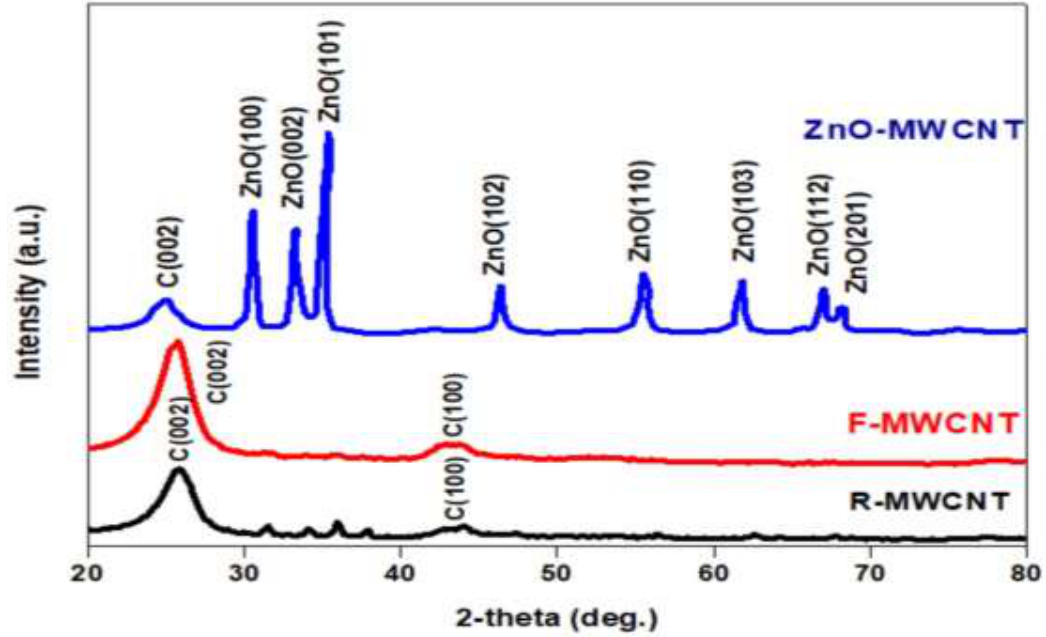
Figure 2: XRD spectra of R-MWCNTs, F-MWCNTs, and ZnO/MWCNTs hybrid. Figure 3 a & 3 b displays the FE-SEM images of the R- MWCNTs before the acid treatment. It was noticed that the R-MWCNTs appears as cylindrical tubes shape with different directions. In addition, the particles tend to agglomerate according to Van der Waals forces between the tubes. After the acid treatment of the F-MWCNTs, it was notable that there was a significant difference in the FE-SEM image as shown in Figure 4 a & 4b. The microscopic images indicate the appearance of nanoparticles in the shape of tangled tubes that look similar a rope. Furthermore, the F-MWCNTs tubes show shorter and have less agglomeration compared to the R-MWCNTs. Additionally, F-MWCNTs structure exhibits irregularity with defects on the surface of the tubes. The mean particle size of R-MWCNTs and F-MWCNTs is (21.06 nm, 33.99 nm), respectively [20]. Figure 5 a & 5 b represents the FE-SEM analysis of the ZnO\MWCNTs hybrid at different magnifications. It was observed that zinc oxide nanoparticles appear in the form of spherical clusters that grow on the surface of tangled tubes that represent the MWCNTs as densely and not uniform. Besides, the distribution of ZnO NPs does not occur in uniform way on MWCNTs. The strong attachment between ZnO and MWCNTs is also due to the interaction between the oxygen groups (functional groups) of both samples. As shown in the image, the hybrid possesses a high surface to volume ratio, which is an important factor for catalysis or surface mediated applications [21]. The results show the success of the ZnO-MWCNTs hybrid synthesis process using the Sol-Gel method